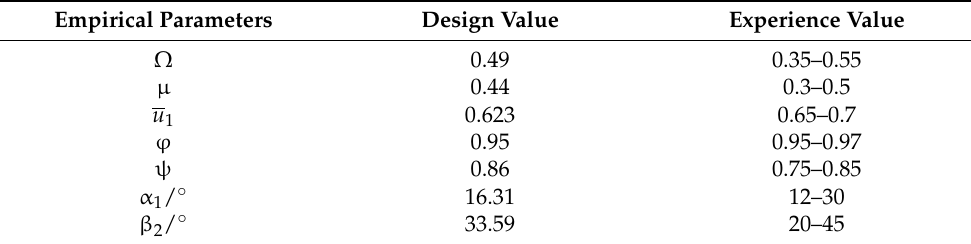
Table 2. The basic parameters and result. Empirical